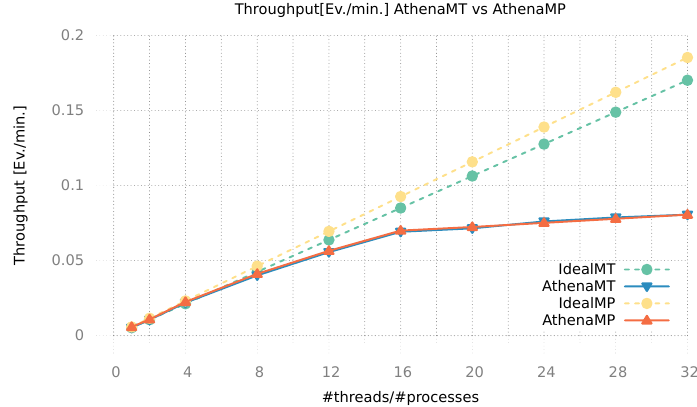
Figure 9: Wall-time speedup of AthenaMT (blue) vs. AthenaMP (orange), compared with the ideal linear scaling in case of weak